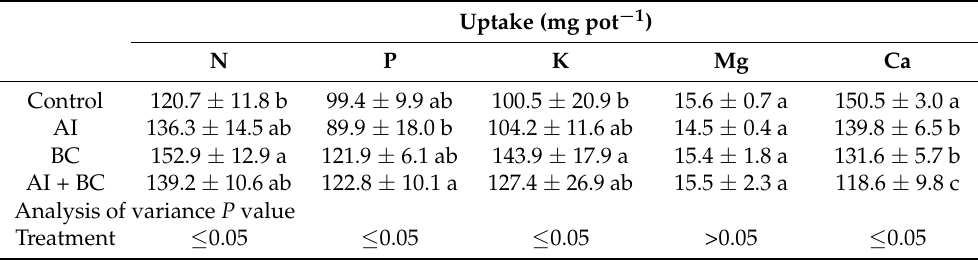
Table 5. Effect of aerated irrigation (AI) and/or biochar (BC) on total mineral nutrient uptake of komatsuna. Values are mean ± standard deviation ( n = 3). Means followed by same letters are not significantly different at the P ≤ 5% level by the LSD